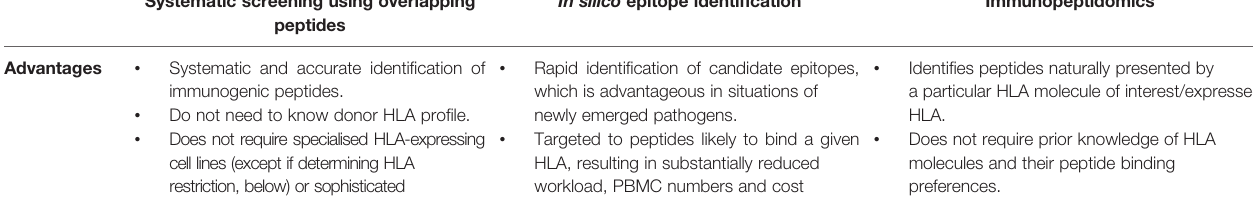
TABLE 2 | Comparing epitope identi fi cation approaches, their advantages and challenges when applied to distinct sets of HLA alleles expressed by Indigenous populations. Systematic screening using overlapping peptides